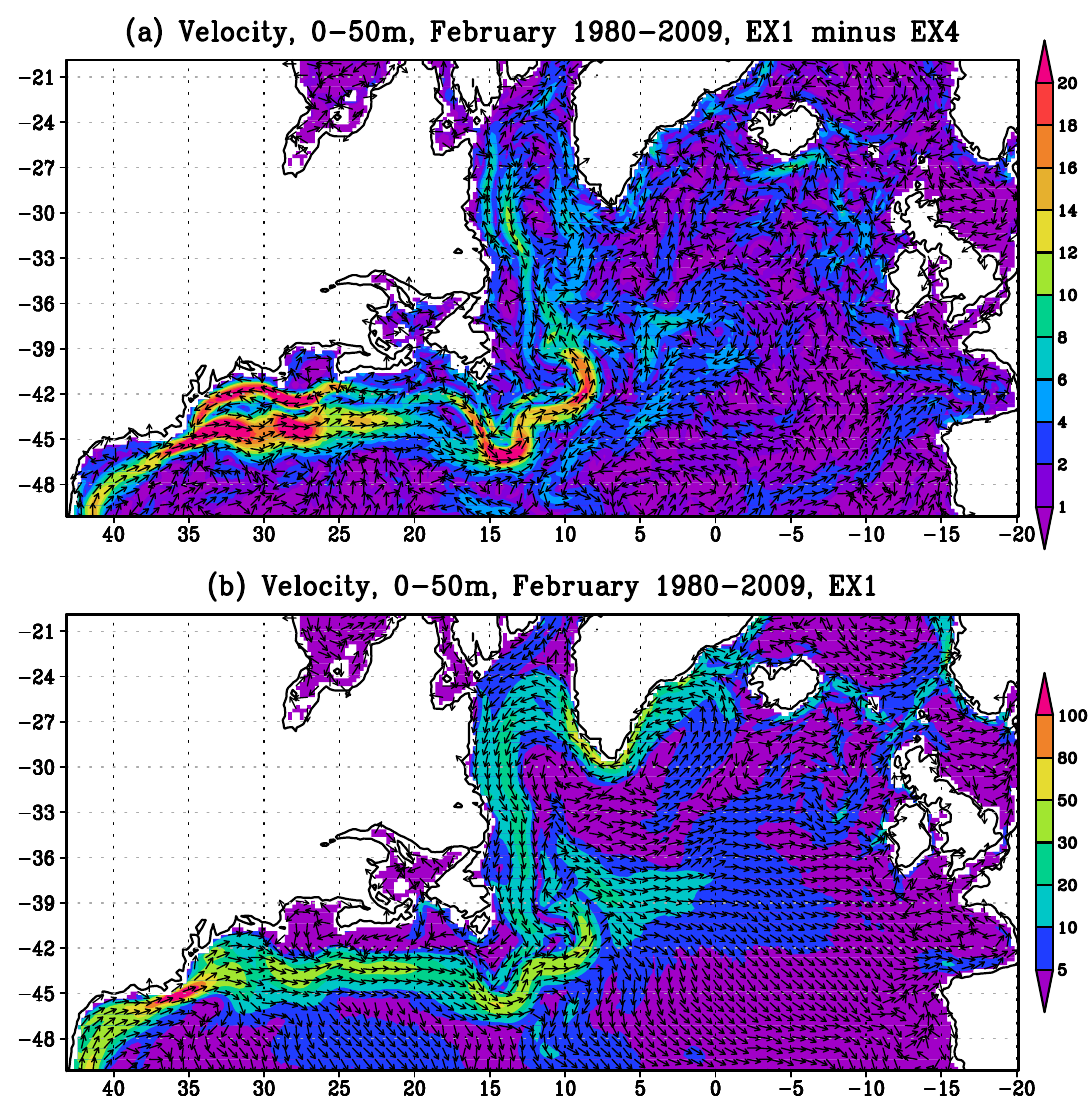
Figure 7. The average in the 0–50 m layer for thirty February of 1980–2009: the difference in the velocities between the EX1 and EX4 (EX1 minus EX4) ( a ); the velocity in the EX1 ( b ). The model coordinates are used (see the caption under Figure 1). The direction is shown by vectors, and the magnitude in cm/s is shown by